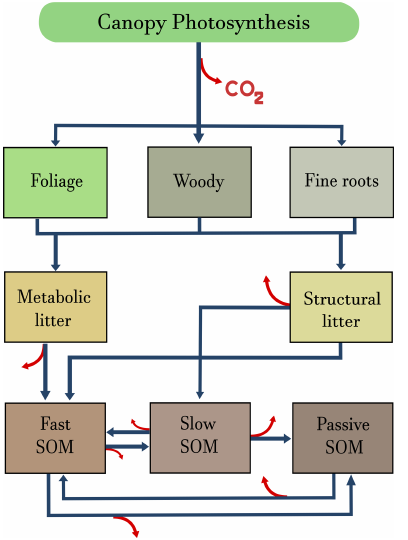
Figure 2. Graphical representation of the terrestrial ecosystem model (TECO) described in Weng and Luo (2011) and Luo et al. (2012). Carbon enters the ecosystem through canopy photosynthe- sis and is allocated to three biomass pools: foliage, woody biomass, and fine roots. From these pools, carbon is transferred to metabolic and structural litter pools, from where it can be respired as CO 2 or transferred to the soil organic matter (SOM) pools. Blue arrows rep- resent transfers among compartments, and red arrows release to the atmosphere in the form of CO 2 .